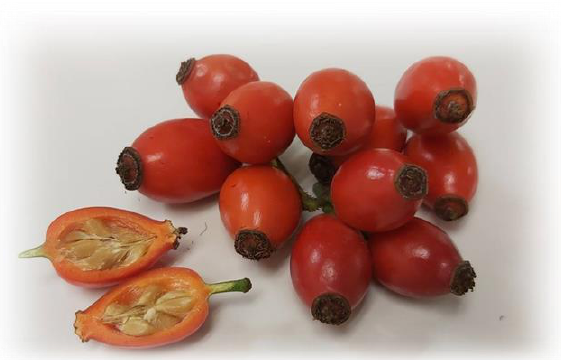
Figure 1. Rose hips of Rosa canina and lengthwise section fruit.